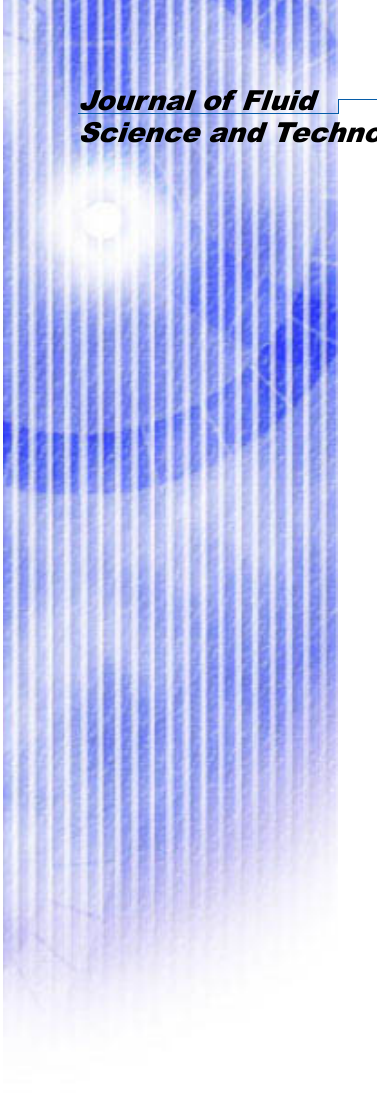
(cid:3404) 0.875 (cid:2998)